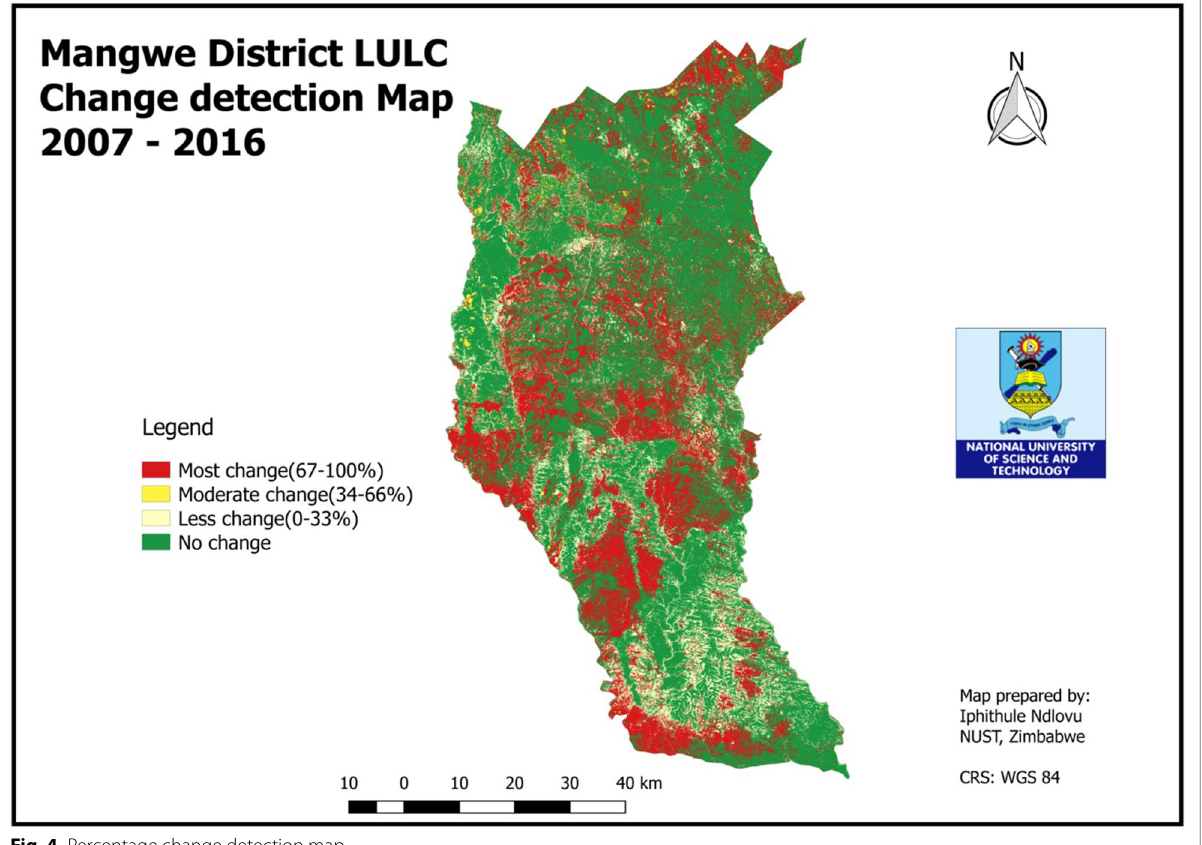
Fig. 4 Percentage change detection map